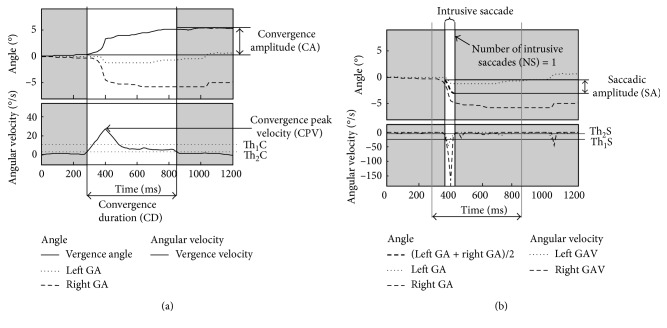
Example of eye movement recordings with ET system and automatic analysis implemented in SacLab to derive the descriptive parameters for fusional response. (a) Analysis of vergence response: identification of convergence using a threshold-based algorithm (Th1C, Th2C) and calculation of convergence parameters (CD = convergence duration; CA = convergence amplitude; and CPV = convergence peak velocity). (b) Analysis of version response: identification of intrusive saccades using a threshold-based algorithm (Th1S, Th2S) and calculation of saccadic parameters (NS = number of intrusive saccades; MSA = mean saccadic amplitude).